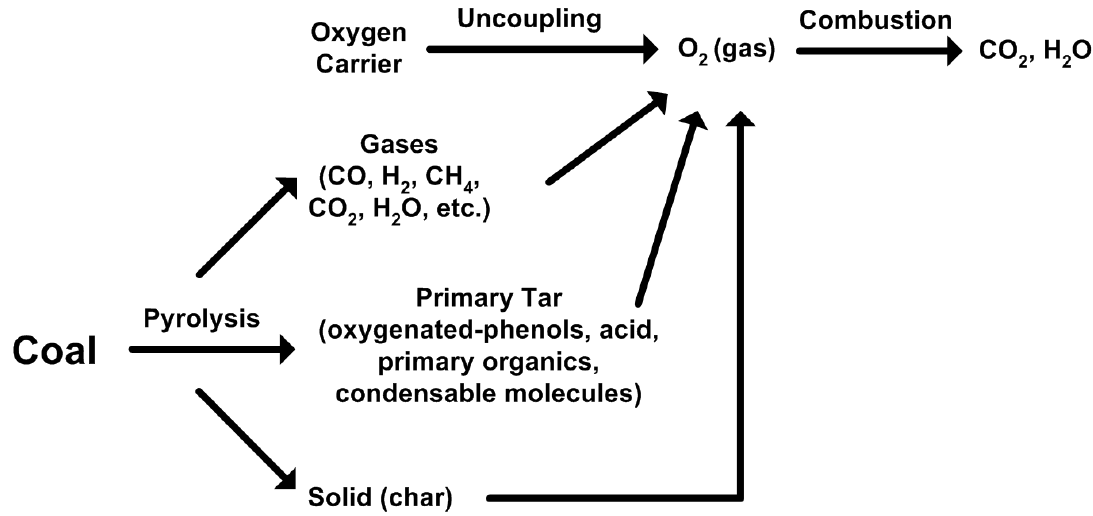
Figure 9. Coal reactions in the fuel reactor for